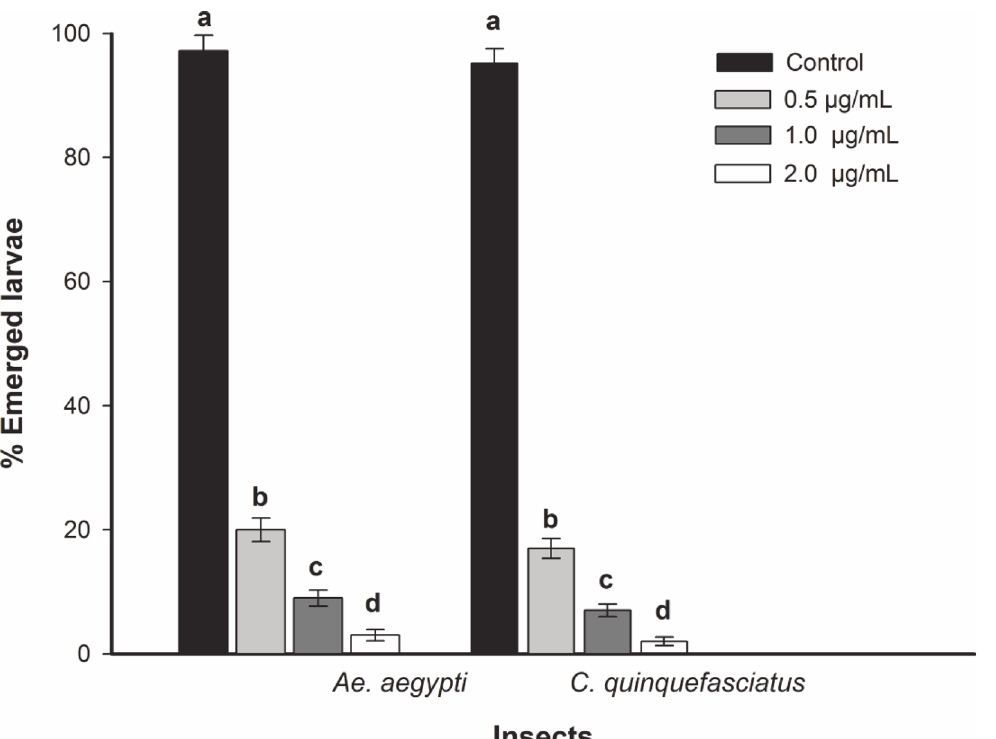
Figure 1. Ovicidal activity of S . guianensis (negramina) essential oil on the emergence of A . aegypti and C . quinquefasciatus larvae. Each datum represents the mean of four replicates. Means followed by different letters are significantly different (P < 0.01) by Tukey ’ s